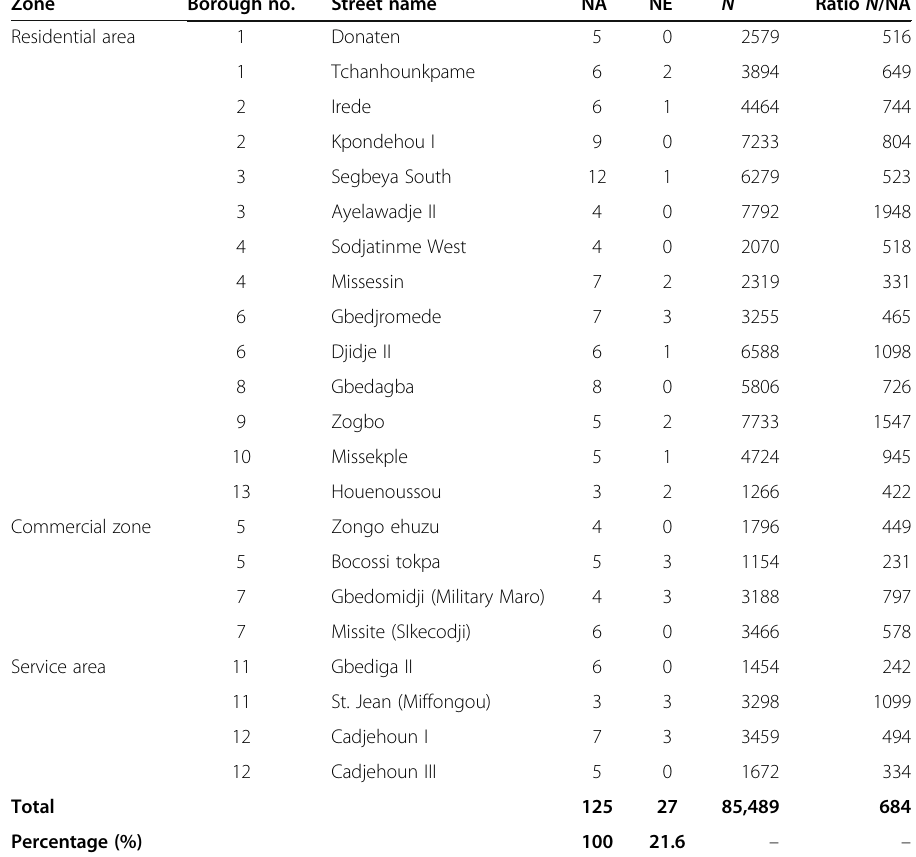
Table 1 Geographical distribution and degree of concentration of “ atta ” production microenterprises in the city of Cotonou Zone Borough